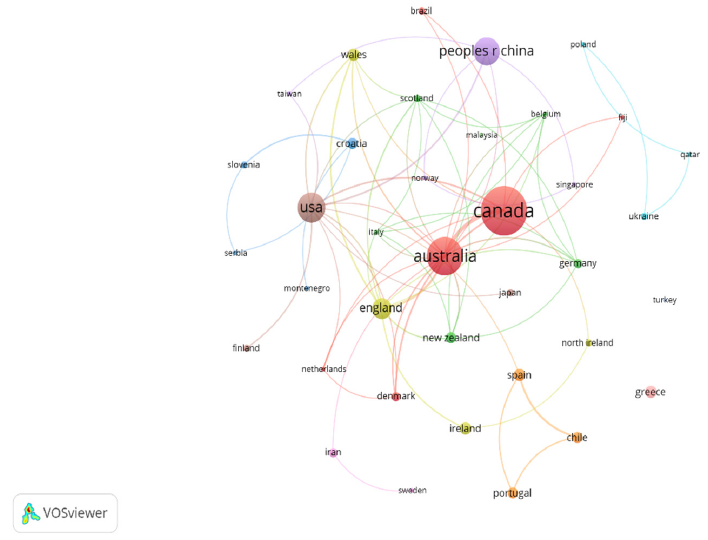
Figure 4. Countries/regions.